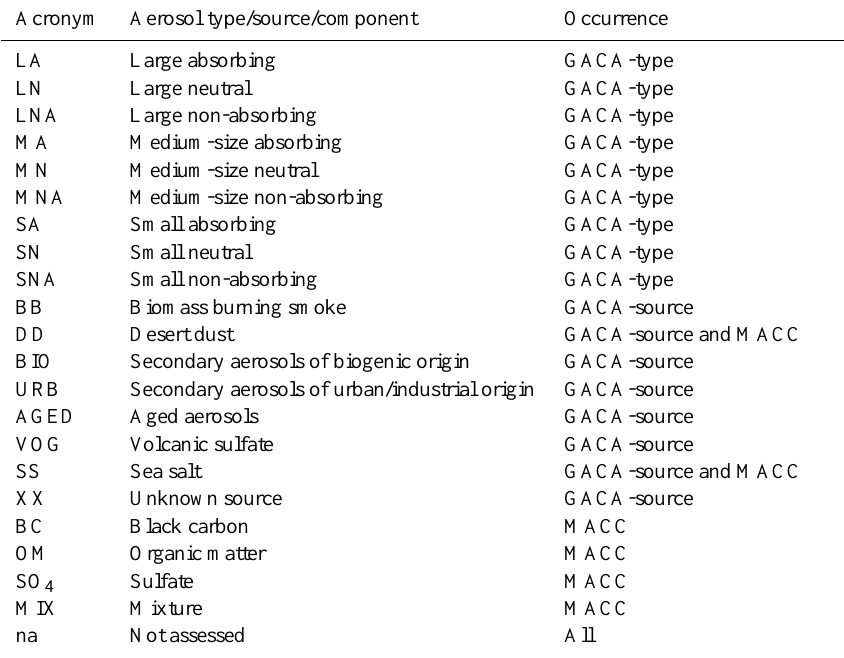
Table 2. Abbreviations of aerosol types and sources used throughout this document.